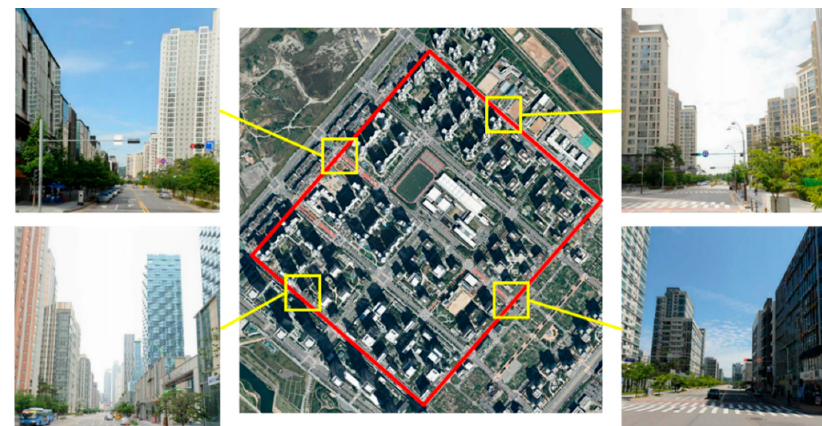
Figure 7. Driving environment in an urban environment with multipath effect that interferes with GNSS satellite signals due to high buildings.